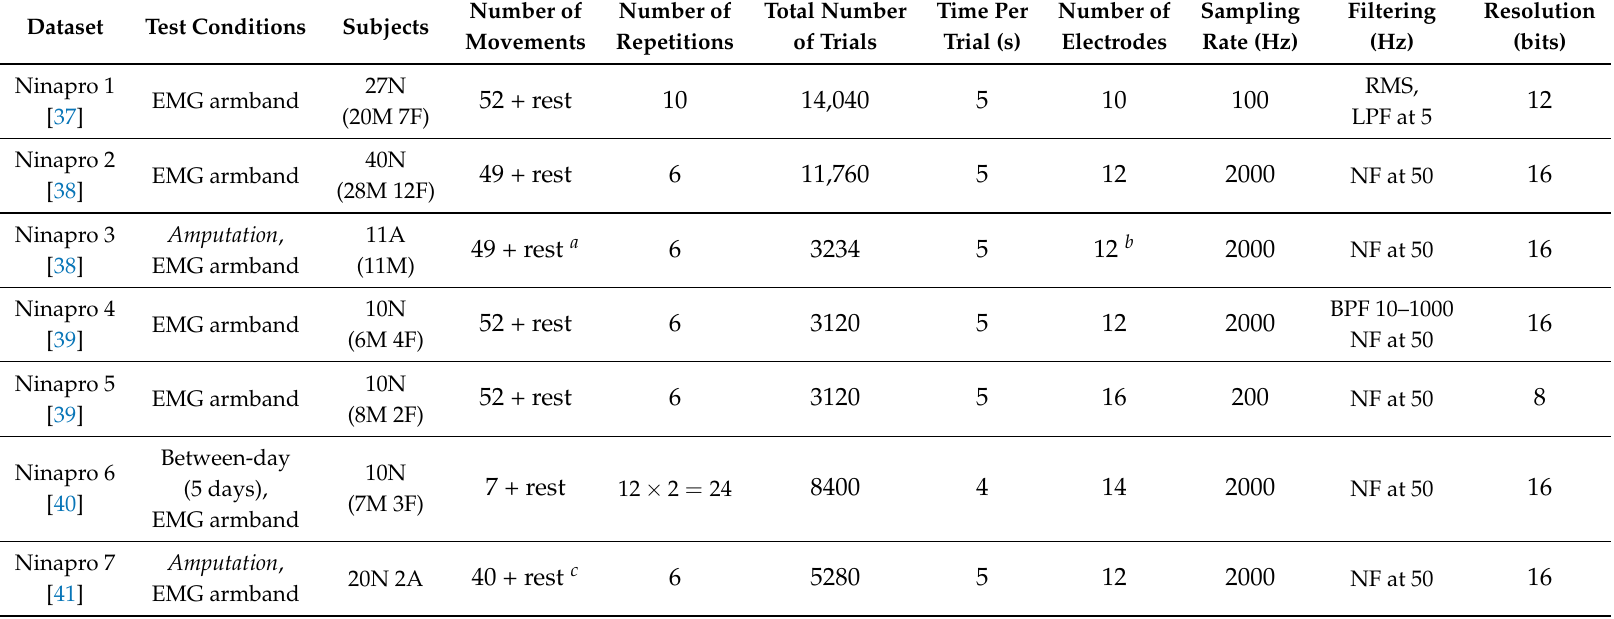
Table 2. Benchmark EMG data sets for myoelectric control: subject, experimental protocol, acquisition setup, and pre-processing